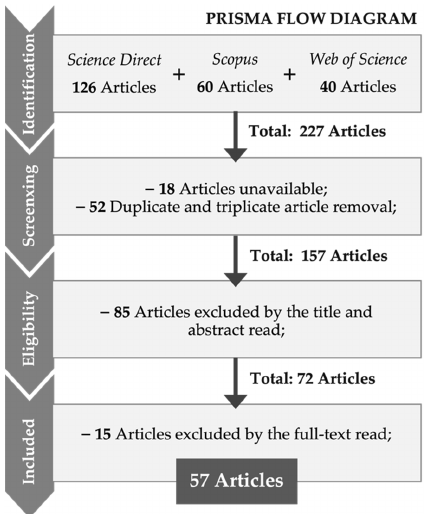
Figure 1. PRISMA flow diagram displaying the results of the systematic research.